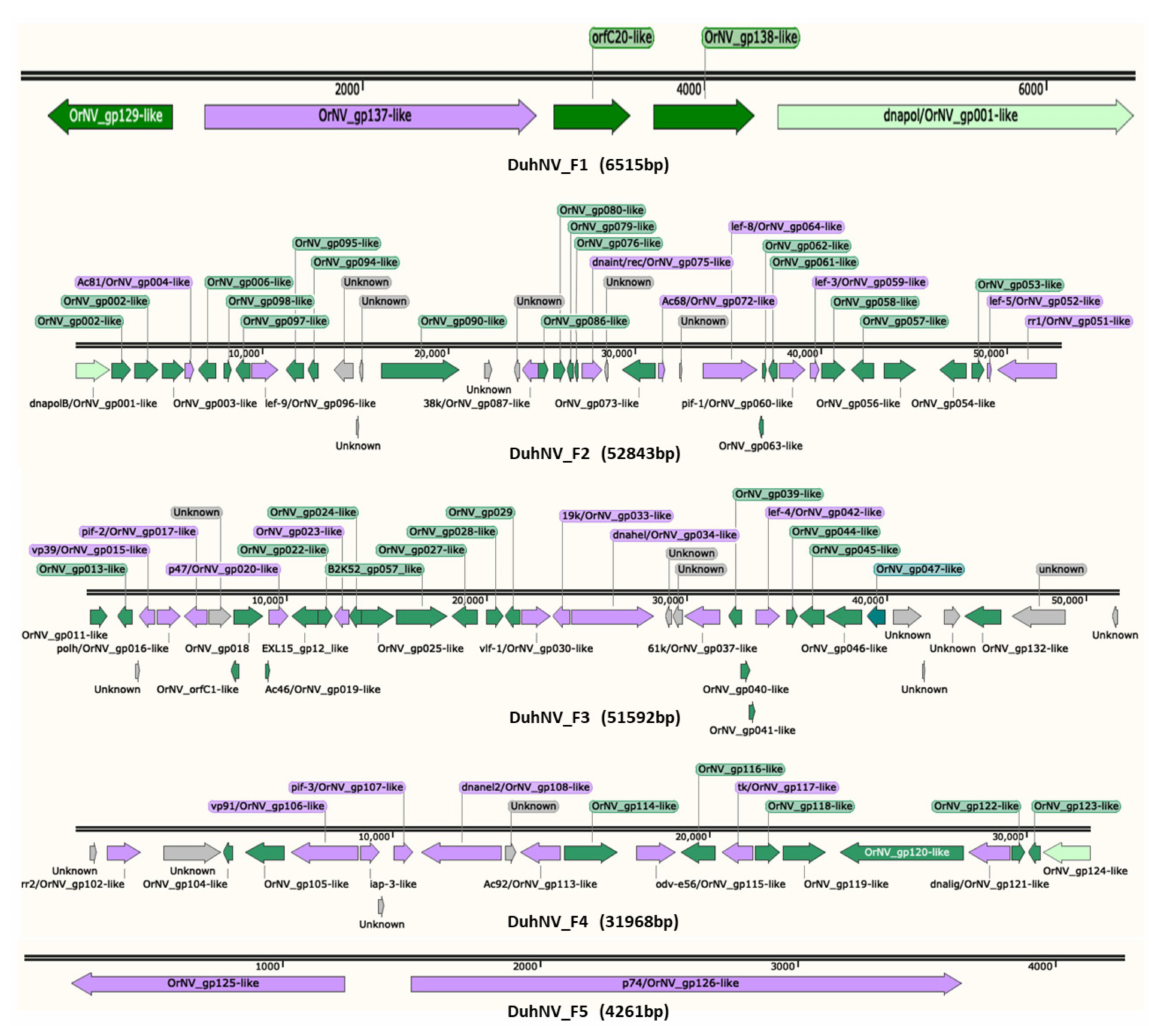
Figure 1. Arrangement of putative genes located on five Diabrotica undecimpunctata howardi nudivirus (DuhNV) genomic fragments ( F1 – F5 ). All ORFs > 50 aa were predicted by BLASTp query against the National Center for Biotechnology Information (NCBI) nr protein database. Arrows indicate ORF direction and orientation. Green, ORFs with BLASTx “hits” to nudiviruses ( E -values ≤ 0.01); purple, core genes; grey, ORFs for hypothetical genes with unknown protein function; light green, partial ORFs (lacking 5 (cid:48) -start or 3 (cid:48) -stop codons). The maps were generated with SnapGene Viewer